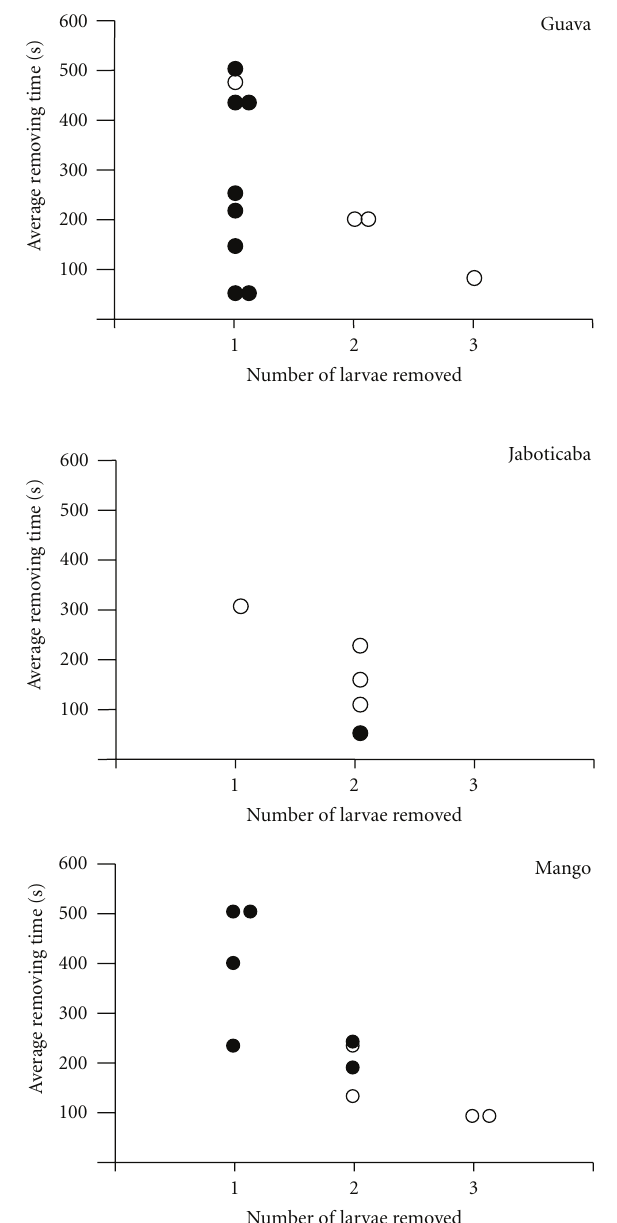
only from 27 samples (12 guavas, five jaboticabas, and 10